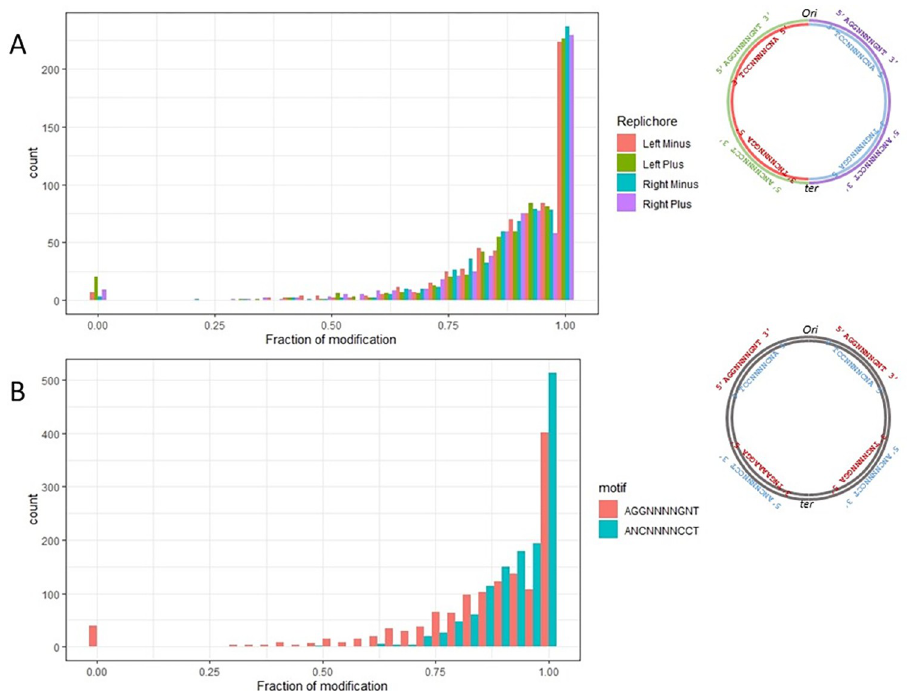
Fig 2. Methylated fraction of each methylation site. A–Number of sites with different fractions of methylation. Colors represent sites located in one of the four parts of the genome: between the origin and midpoint of the chromosome, on the plus or minus strand. The panel on the right schematically shows the methylation sites that were counted in each group. B–Number of sites with different fractions of methylation. In this figure, the location of sites in the genome has not been considered. Colors represent the sites on the ANCNNNNCCT or AGGNNNNGNT strands in the double-stranded methylation motif. The panel on the right schematically shows the methylation sites that were counted in each